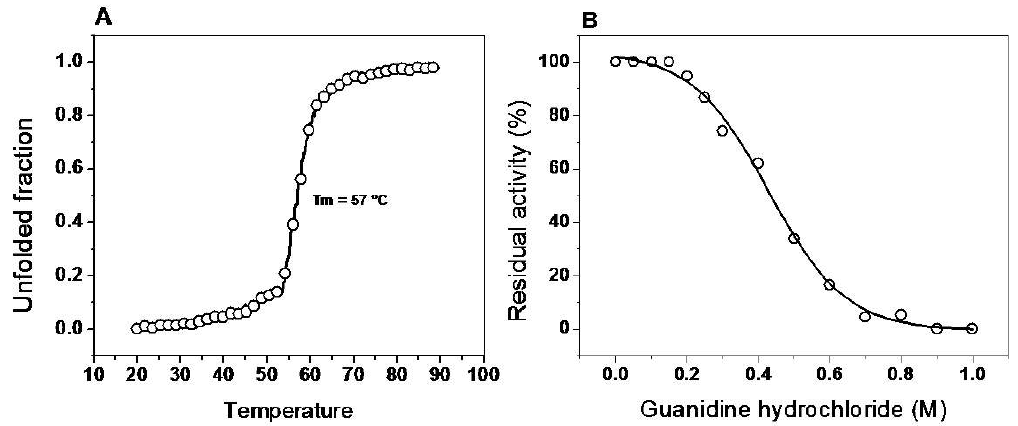
Figure 7. Stability analysis of recombinant G6PD::6PGL from G. lamblia . ( A ) Thermal stability. Changes in the circular dichroism (CD) signal at 222 nm were monitored as the temperature increased from 20 °C to 80 °C. ( B ) Stability analysis of protein in the presence of Gdn-HCl (0 to 1 M). The protein was incubated at 0.2 mg/mL in 50 mM Tris buffer pH 8.75 in the presence of the indicated concentrations of Gdn-HCl for 2 h at 37 °C and subsequently the enzymatic activity was measured. Residual activity for G6PD was expressed as a percentage of the activity for the same sample measured at 25 °C, without Gdn-HCl, and were diluted immediately before use. The experiments were performed in triplicate.